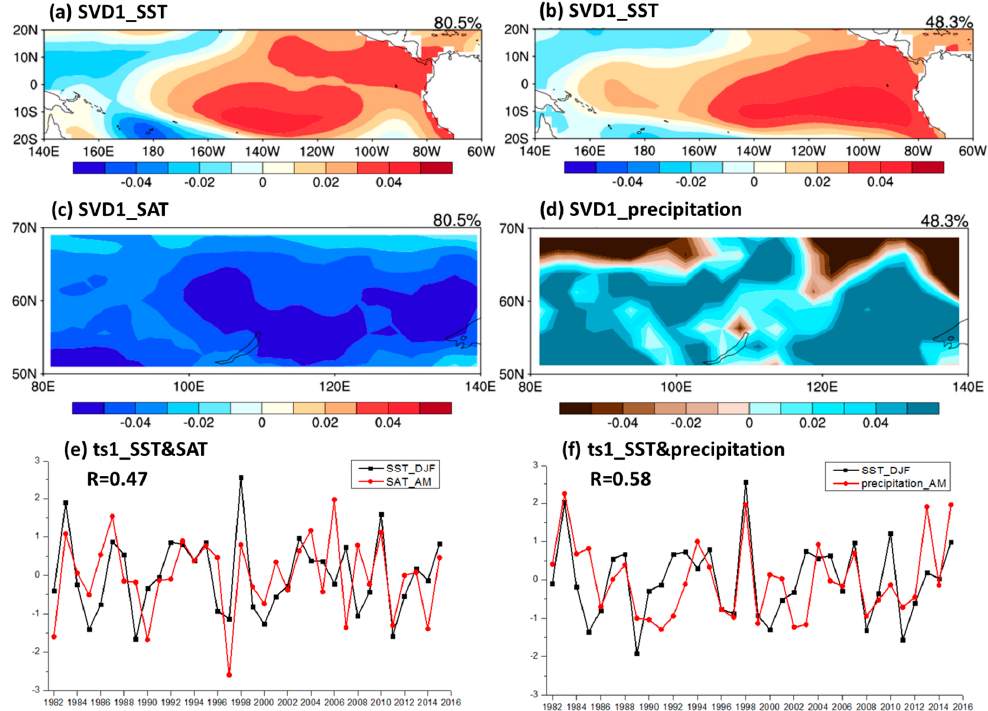
Figure 6. Spatial patterns and time-series of expansion coefficients for the first leading paired mode of winter SST (tropical Pacific) and spring surface air temperature (SAT) and precipitation over East Russia for the period 1982 to 2015 via the SVD analysis: ( a ) the paired mode of SST using SAT; ( b ) the paired mode of SAT; ( c ) the paired mode of SST using precipitation; ( d ) the paired mode of precipitation; ( e ) the time-series of SST (black squares) and SAT (red dots); ( f ) the time-series of SST (black squares) and precipitation (red dots). The time-series amplitudes are normalized based on standard deviation. The variance explained by each SVD is shown on the right corner in ( a – d ).